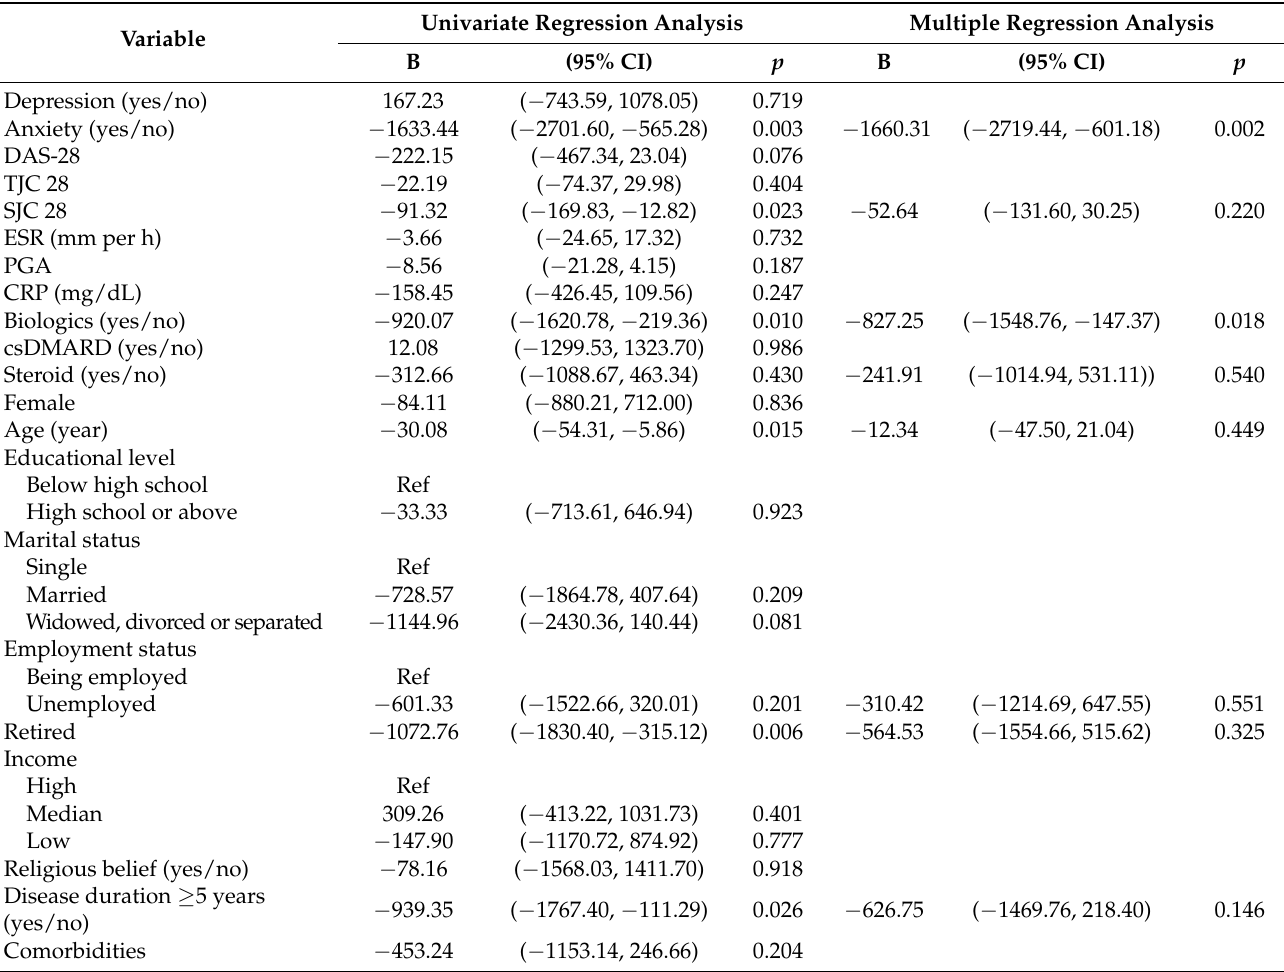
Table 1. Univariate and multiple linear analyses of clinical parameters associated with serum levels of BDNF in patients with rheumatoid arthritis (RA) ( N = 625). Univariate Regression Analysis Multiple Regression